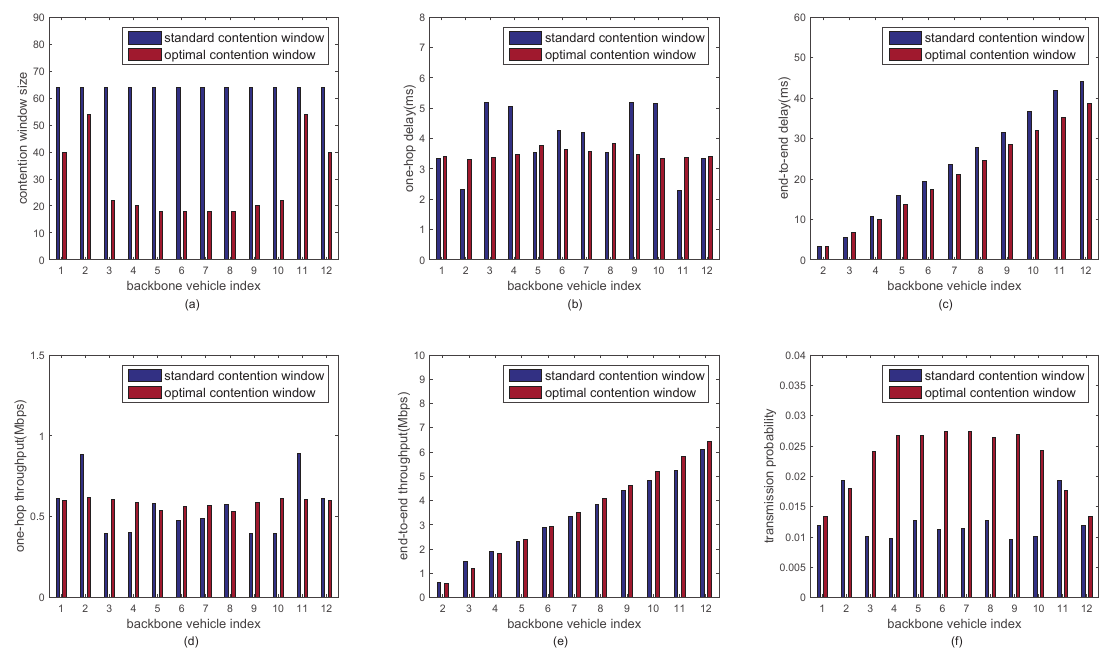
Figure 6. The performance of inter-platoon communications under 12 backbone vehicles. ( a ) Minimum contention window size vs backbone vehicle index; ( b ) One-hop delay vs backbone vehicle index; ( c ) End-to-end delay vs backbone vehicle index; ( d ) One-hop throughput vs backbone vehicle index; ( e ) End-to-end throughput vs backbone vehicle index; ( f ) Transmission probability vs backbone vehicle index.